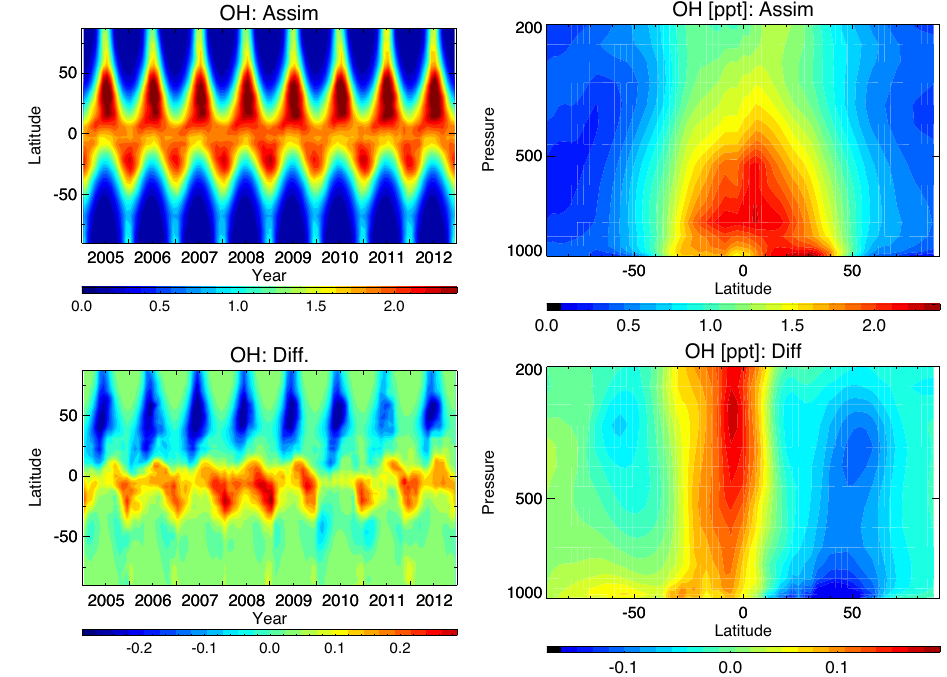
Figure 18. Latitude–pressure cross section of the 8-year mean OH concentration (right panels) and time–latitude cross section of the monthly mean OH concentration averaged between 1000 and 300hPa (left panels). The OH concentration obtained from the reanalysis (top panels) and the difference between the reanalysis and the control run (bottom panels) are also shown. Units are